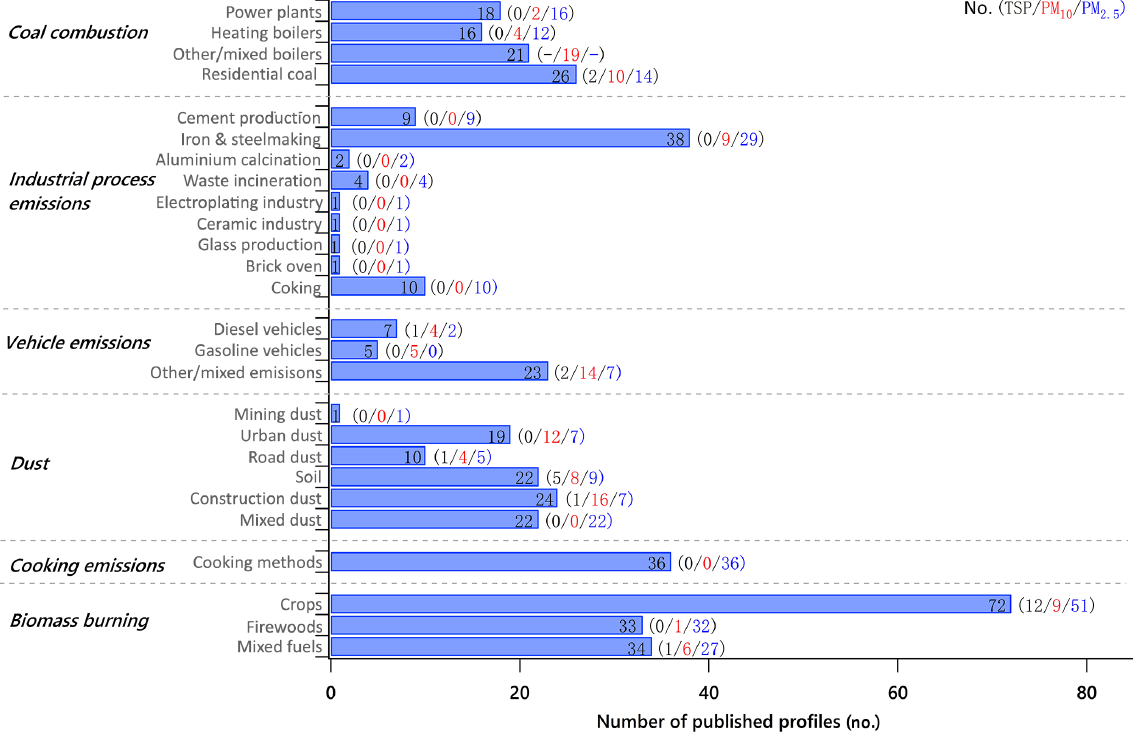
Figure 1. Overview of the published source profiles across China. The numbers inside the bars refer to the total number of published profiles for specific source subtypes, whereas the numbers after the bars denote the number of profiles based on measurements of total suspended particles (TSP), PM 10 , and PM 2 . 5 , respectively (see